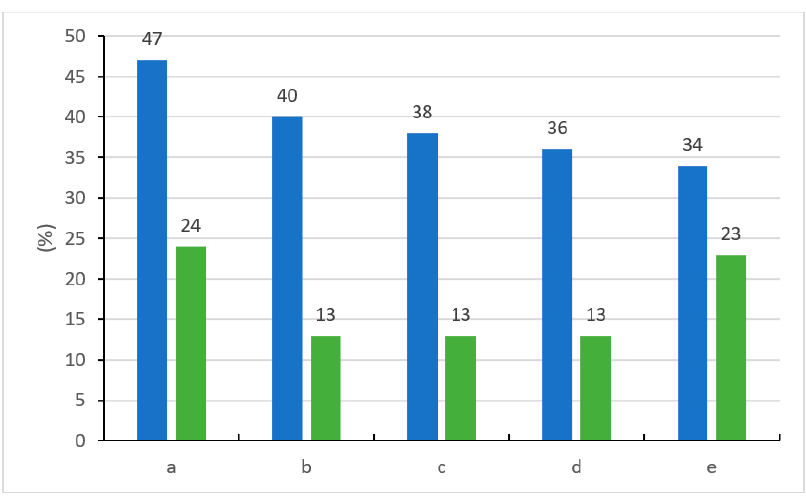
Figure 8. Self-assessment of the EU awareness.